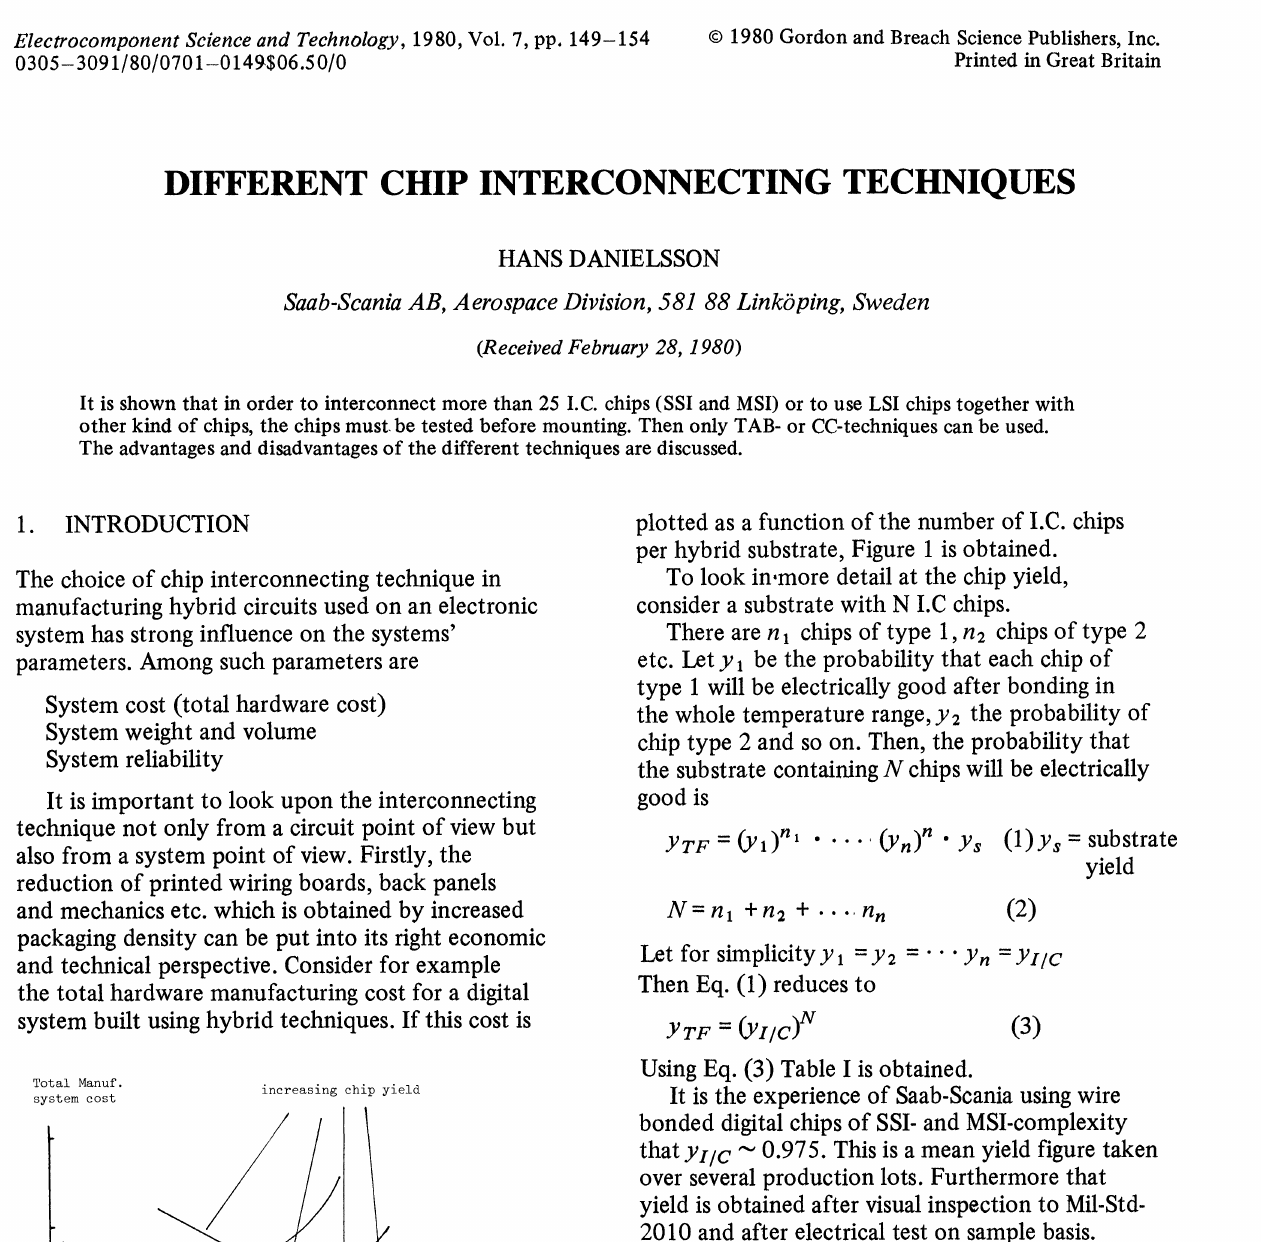
Importance of chip yield in hybrid circuit